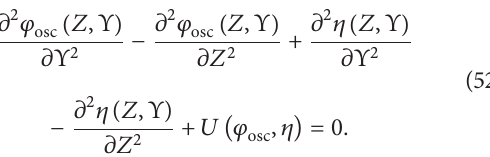
, 𝜂) is a function which depends on the form of where 𝑈(𝜑 osc (𝜑 ) . In order to decouple the above equation, we apply 𝑉 𝜑 sol sol the rotation (18) and the dilations 𝑇 = √ℎ 1 Υ and 𝑋 = √ℎ 2 𝑍